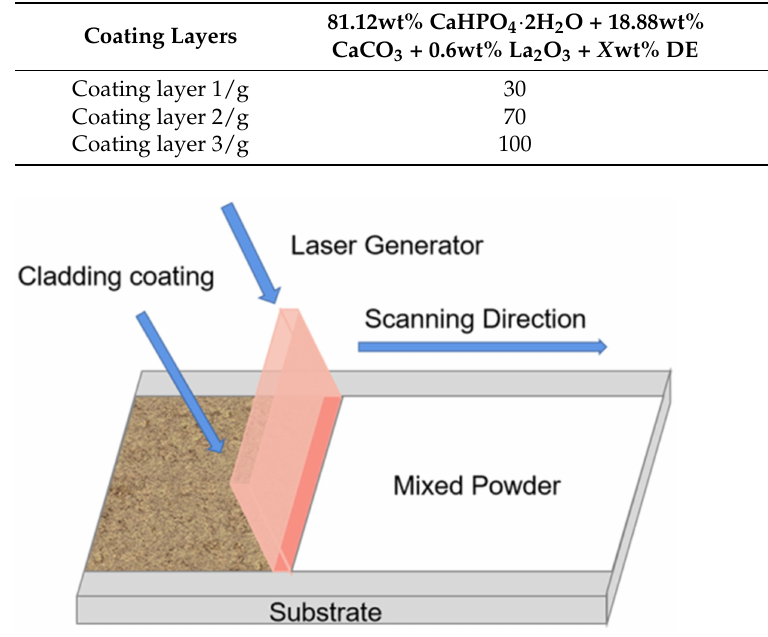
Figure 1. Diagrammatic sketch of broadband-laser